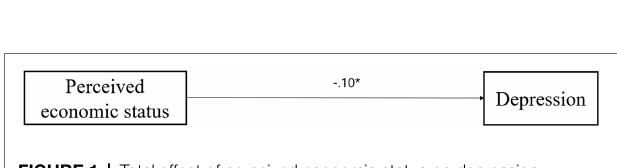
FIGURE 1 | Total effect of perceived economic status on